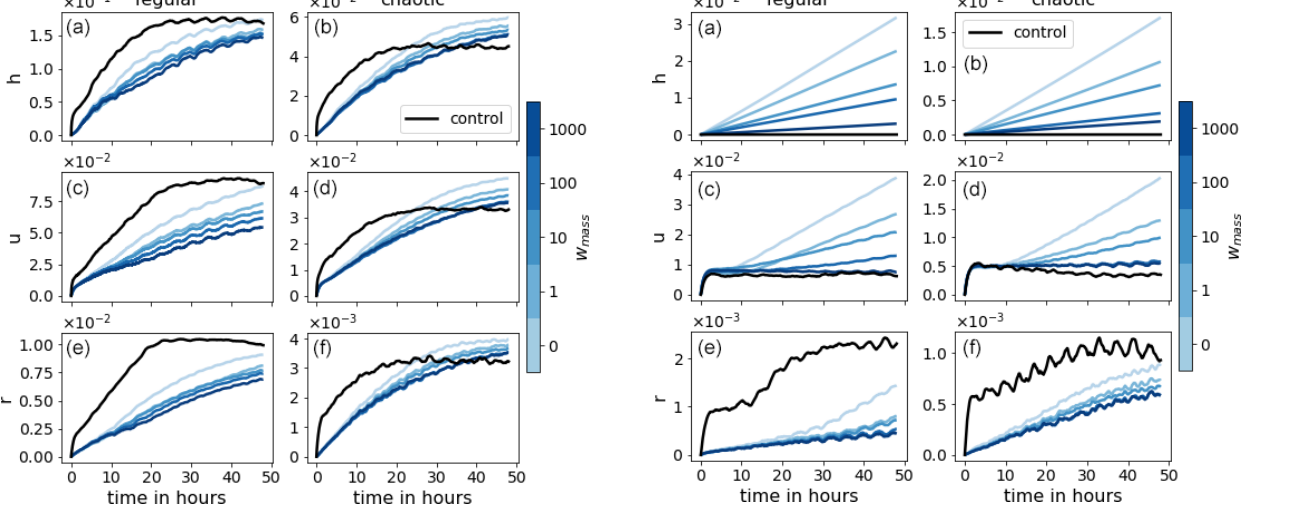
Figure 9. The RMSE evolution of 48h forecasts for model variables h , u , and r (from top to bottom) of LR (black) and LR ANN for the different weightings (blue colors).